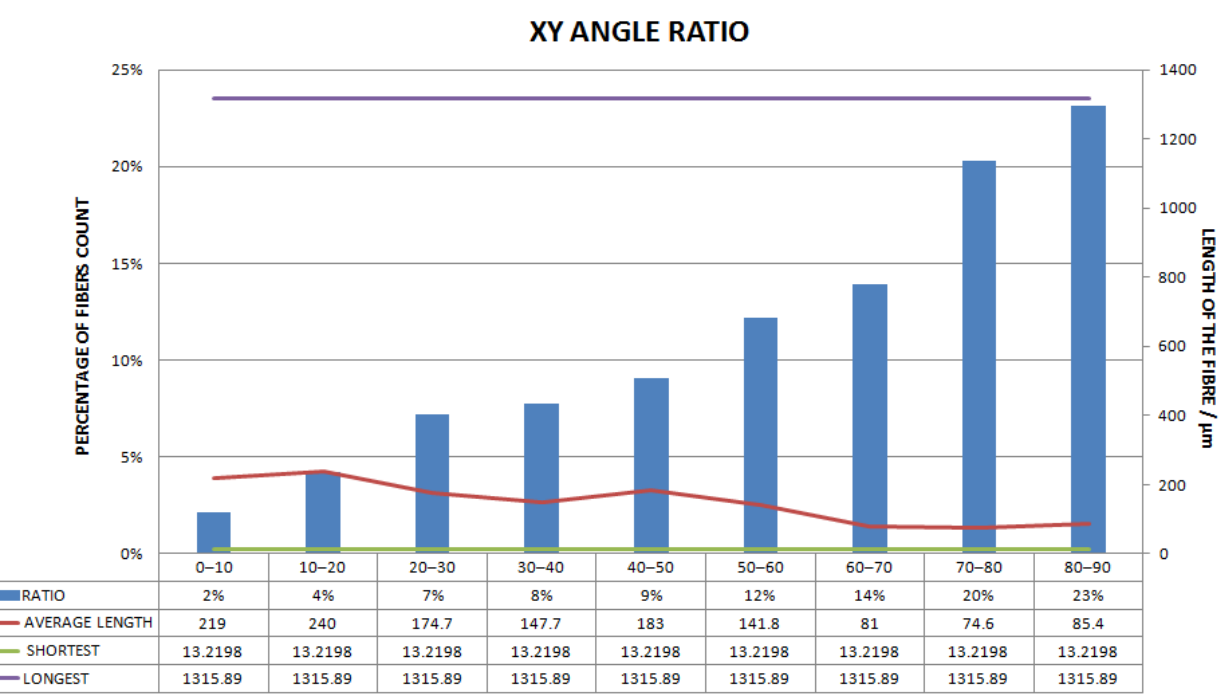
Figure 21. Statistical diagram of the angle between polyester short fibers reconstructed by Avizo software and the XY direction.